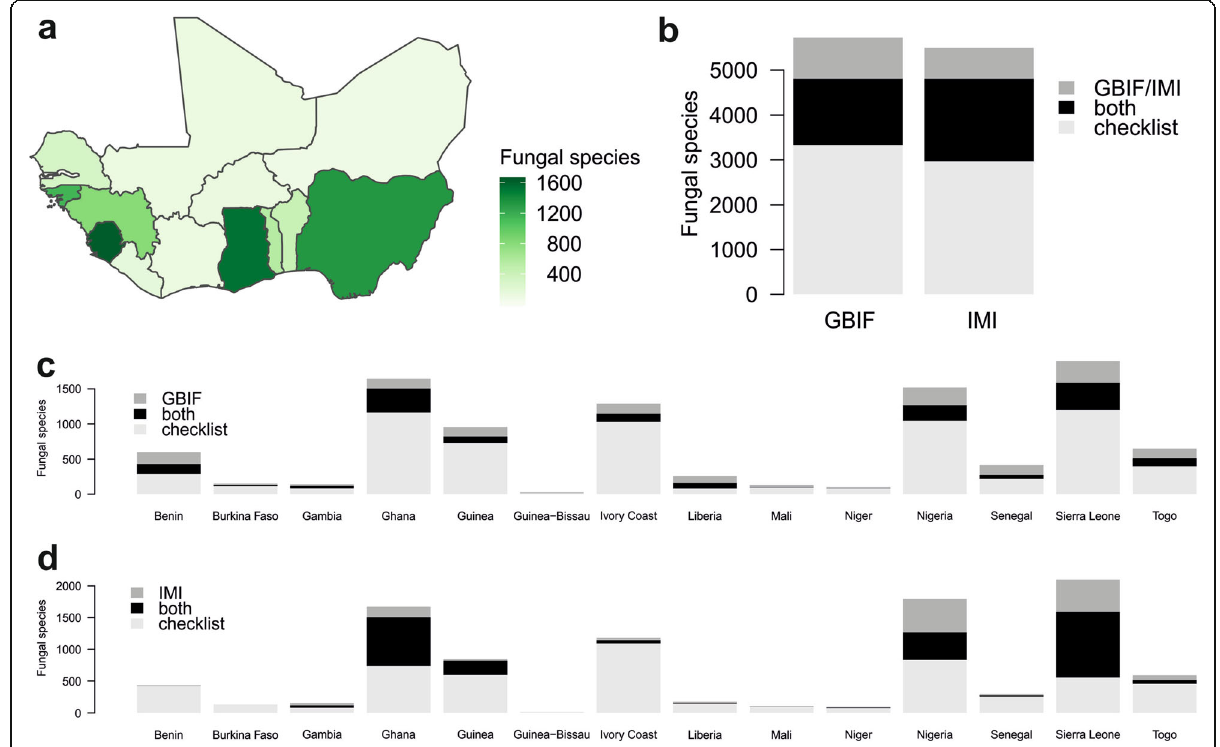
Fig. 2 Knowledge of fungal species diversity in West Africa and West African countries. a Map of West African countries with colour intensities relative to the number of fungal species known per country according to the checklist based on literature. b Number of fungal species known for West Africa by the checklist based on literature only (light grey), by the checklist based on literature and the GBIF database or the IMI fungarium database (black), and only by GBIF/IMI (dark grey). c Number of fungal species known for West African countries by the checklist based on literature only (light grey), by this checklist and GBIF (black), and only by GBIF (dark grey). d Number of fungal species known for West African countries by the checklist based on literature only (light grey), by this checklist and IMI (black), and only by IMI (dark